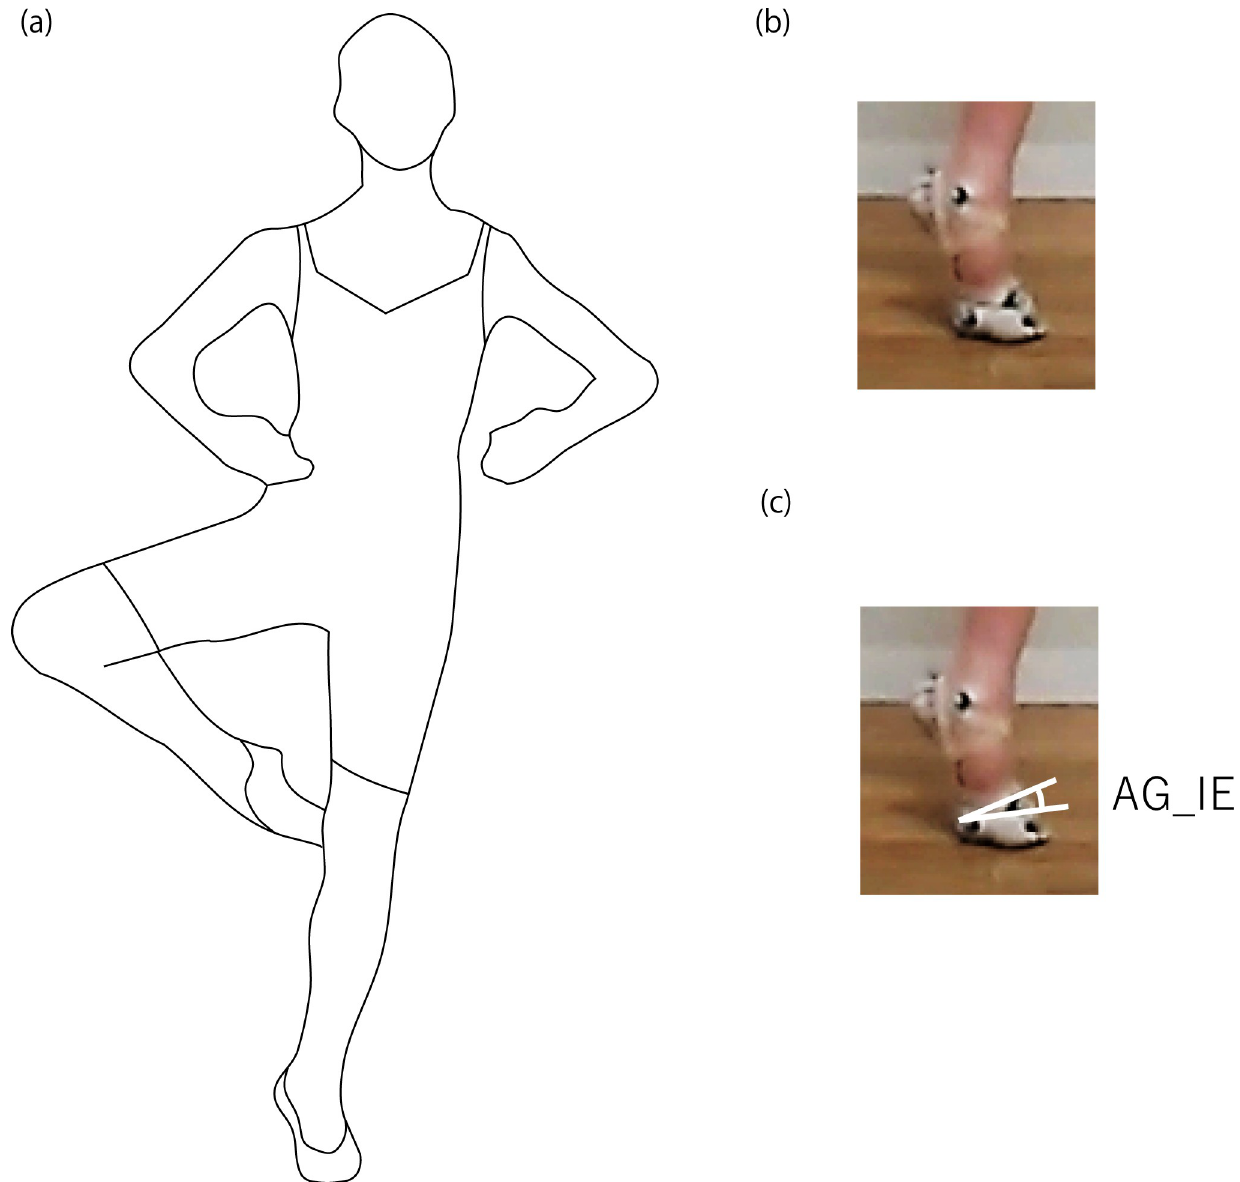
Fig 1. Posture during tiptoe standing on a single leg. (a) Dancers kept their balance on a supporting leg without external support. (b) The metatarsophalangeal and ankle joints in the supporting leg are extended and plantarflexed, respectively, during tiptoe standing. (c) The measured foot inversion/eversion angle (AG_IE) in this